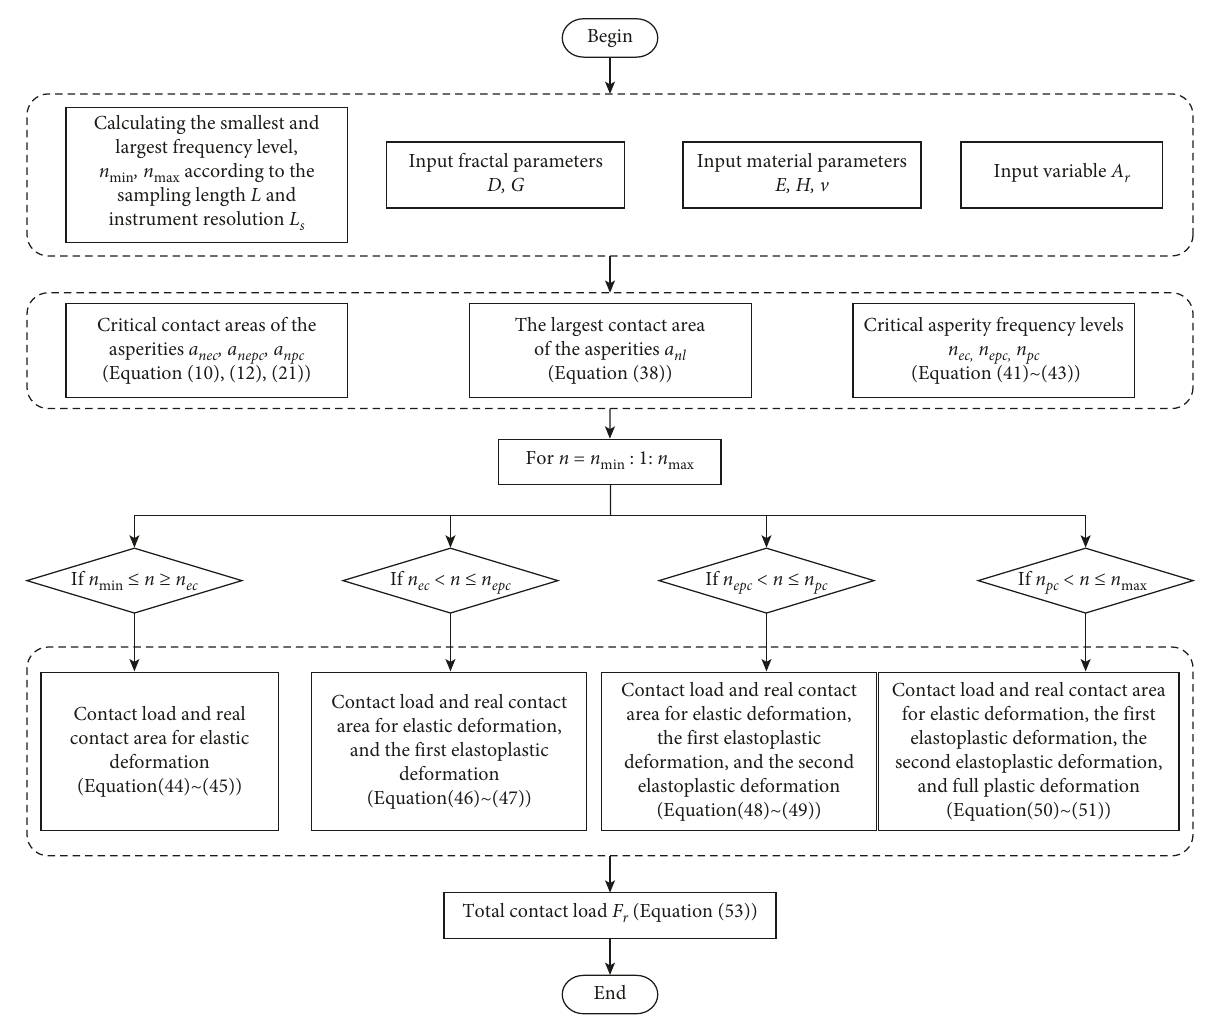
Figure 4: Flowchart for extracting the relationship between the total real contact area and contact load. Table 1: Equivalent rough surface